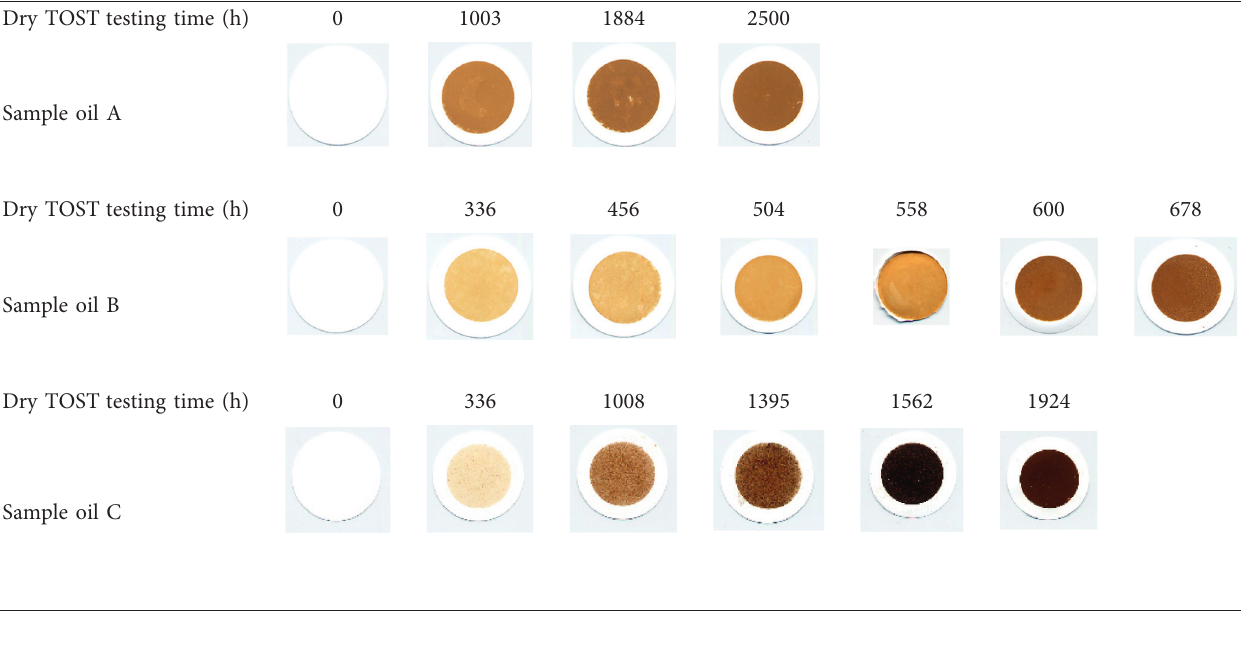
Table 2: Membrane patch images and RGB